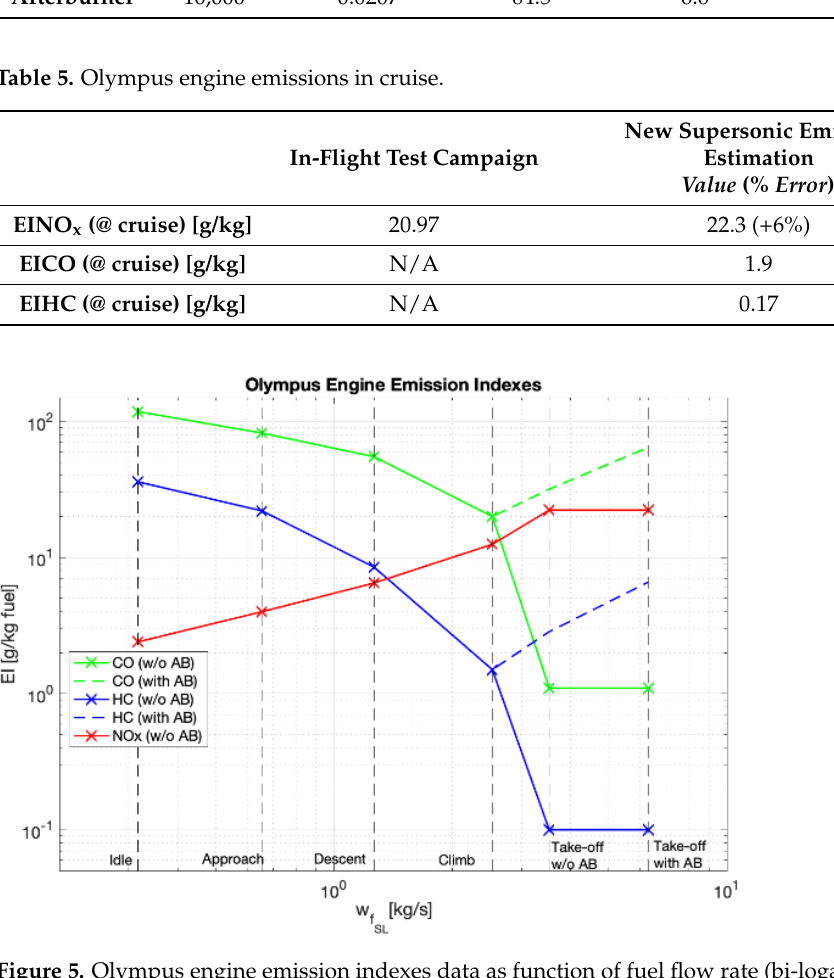
Figure 5. Olympus engine emission indexes data as function of fuel flow rate (bi-logarithmic).